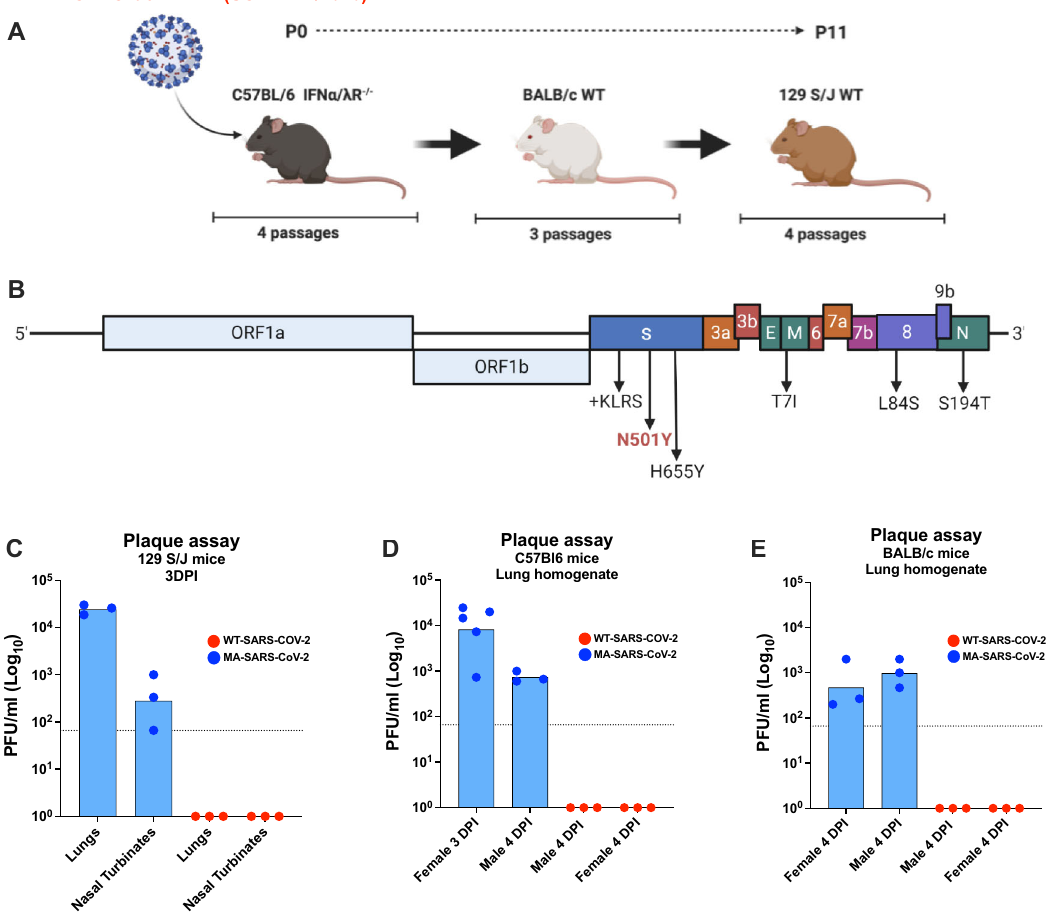
Fig. 1 Mouse-adaptation strategy and lung virus titers upon challenge with WT- and MA-SARS-CoV-2. A The SARS-CoV-2 USA-WA1/2020 Seattle strain was obtained from BEI Resources and serially passaged 11 times in mice of different genetic backgrounds. B Sequence and location of mutations identi fi ed in MA-SARS-CoV-2 when compared to WT-SARS-CoV-2. C Infection with 2.5 × 10 4 PFU of the MA-SARS-CoV-2 resulted in detectable virus titers in lungs (right lung lobes were used for titration) and nasal turbinates at 3 DPI in female 129S1 mice whereas the WT-SARS-CoV-2 did not. D Infection with 2.5 × 10 4 PFU of MA-SARS-CoV-2 but not WT-SARS-CoV-2, resulted in detectable lung virus titers harvested at different time points post-infection in C57Bl6 as well as E BALB/c mice irrespective of sex. Bars represent geometric means. Dotted line indicates limit of detection (LOD) − 66.67 PFUml − 1 . Each data point corresponds to one mouse and the number of data points represents the number of mice in the corresponding groups. Source data are provided as a Source Data fi